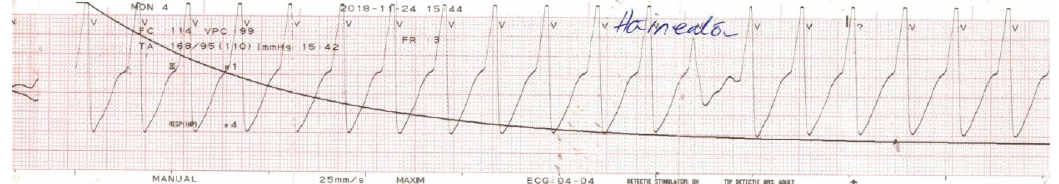
Figure 1. Electrocardiogram (ECG) strip showing ventricular tachycardia .